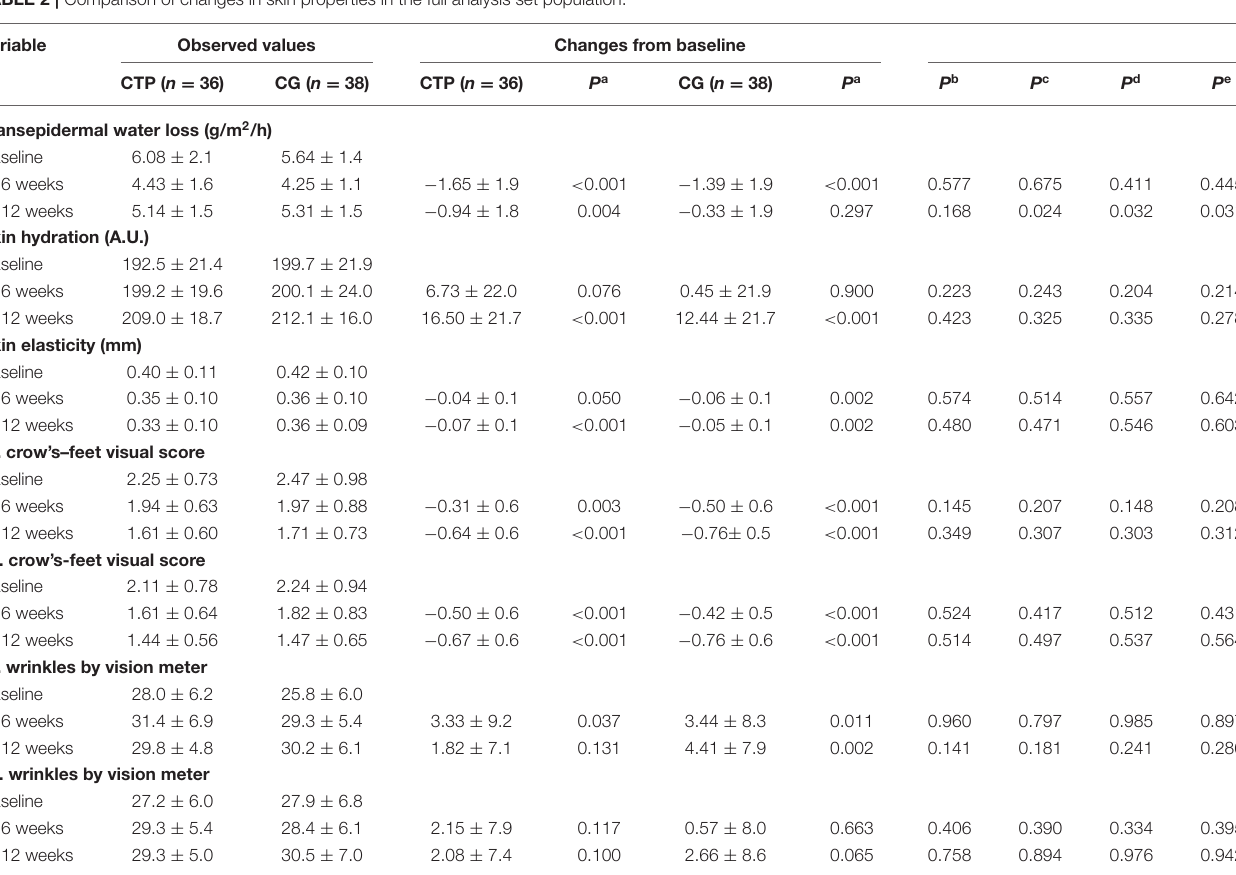
TABLE 2 | Comparison of changes in skin properties in the full analysis set